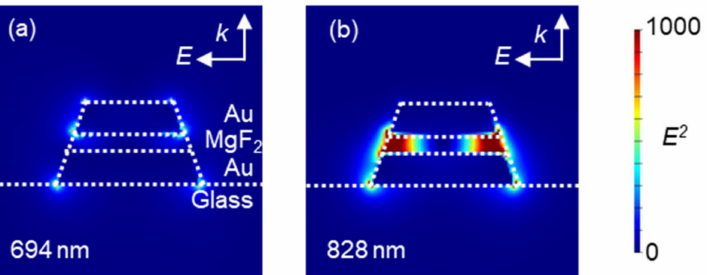
Figure 7. Simulated electric field distribution of MIM nanostructures imitating the SEM images at ( a ) the 694 nm wavelength and ( b ) the 828 nm wavelength. The white arrows in the figures indicate the state of electric field irradiated to the nanostructure to excite the LSP.